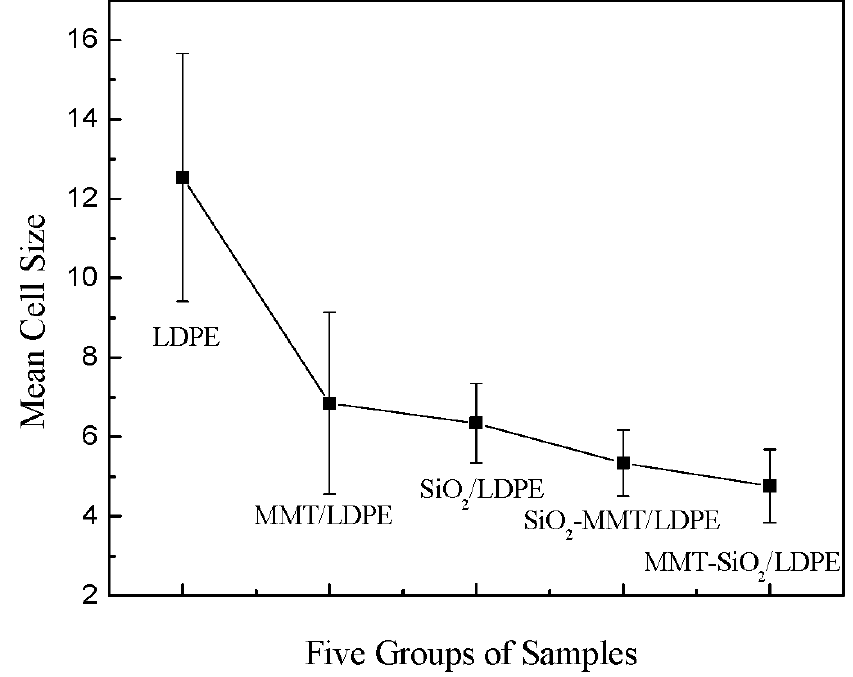
Figure 3. Statistical distribution of crystal cell size of each sample.